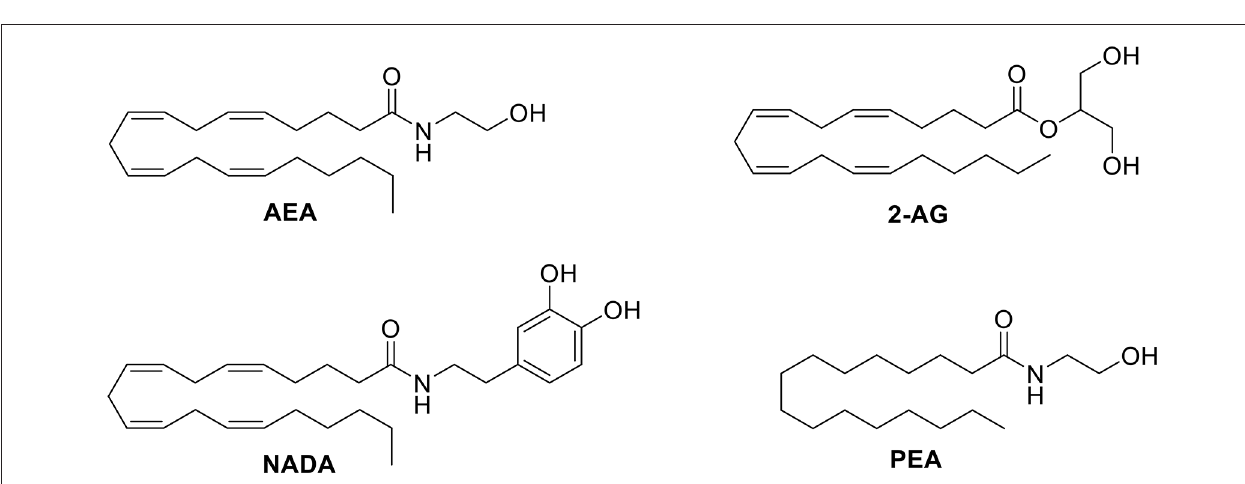
FIGURE 4 | Structure of selected endocannabinoids that target TRP